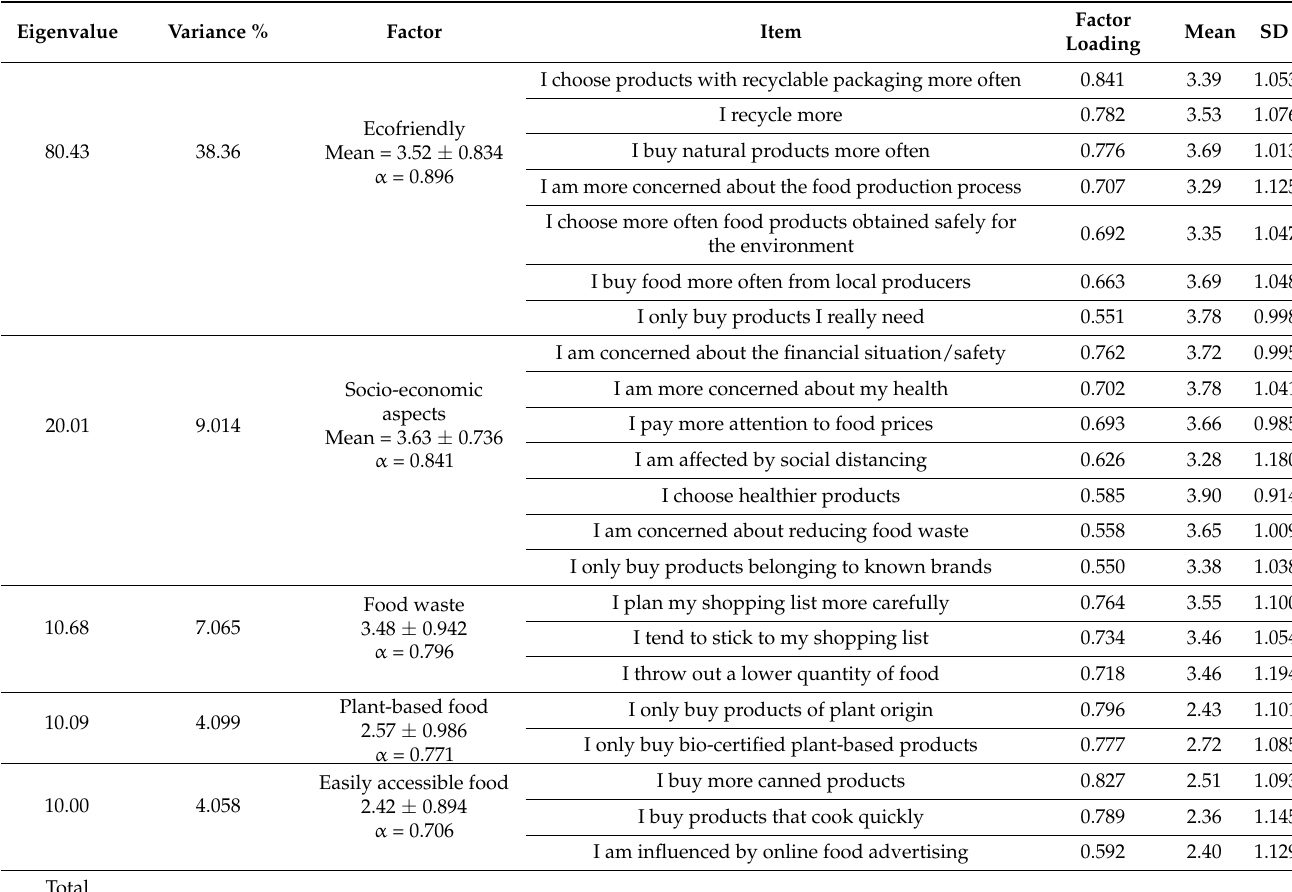
Table 2. Principal component